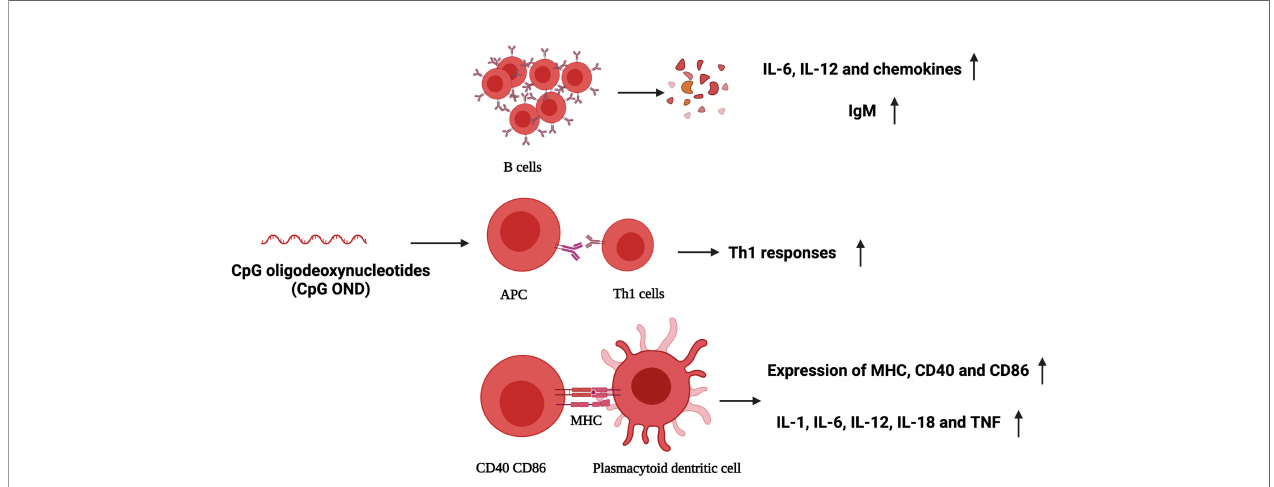
FIGURE 3 | CpG oligodeoxynucleotides (ODNs) activate plasmacytoid dendritic cells and human B cells directly, and stimulate the creation of T helper 1 (TH1)-type cytokines. IL, interleukin; IgM, immunoglobulin M; TH1, T helper 1 (TH1)-type cytokines; CD40, CD86, markers of activation and maturation of dendritic cells; MHC, major histocompatibility complex; TNF, tumor-necrosis